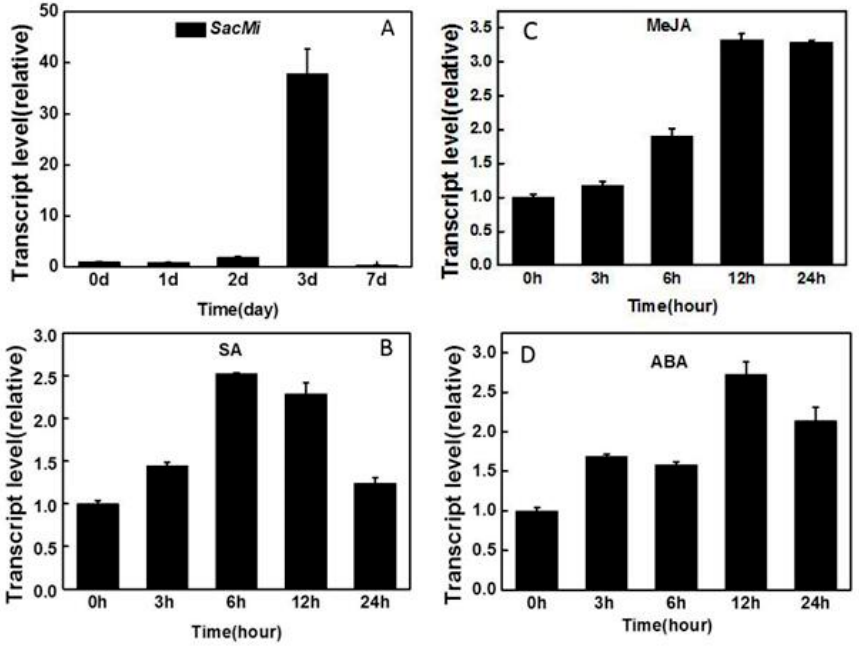
Figure 5. Expression profiles of SacMi gene in response to M. incognita inoculation ( A ); SA treatment ( B ); MeJA treatment ( C ); and ABA treatment ( D ).